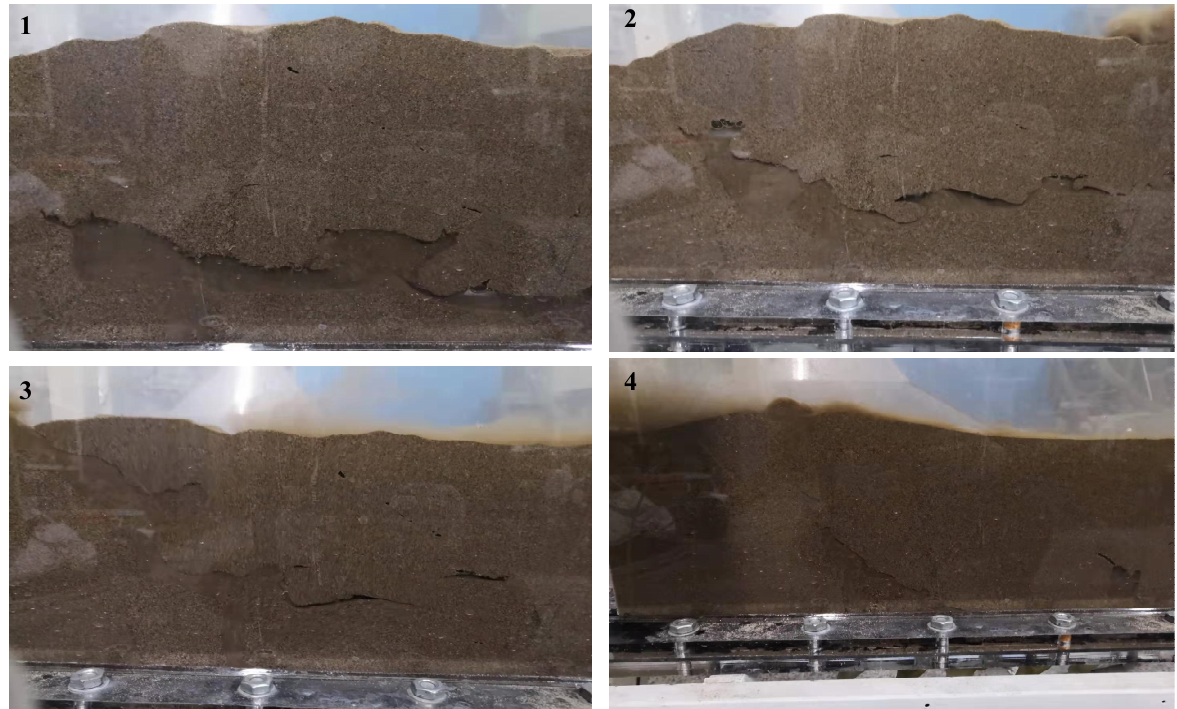
Figure 5. Experimental observation of the evolution (from 1 to 4) of the fluidized zone height.